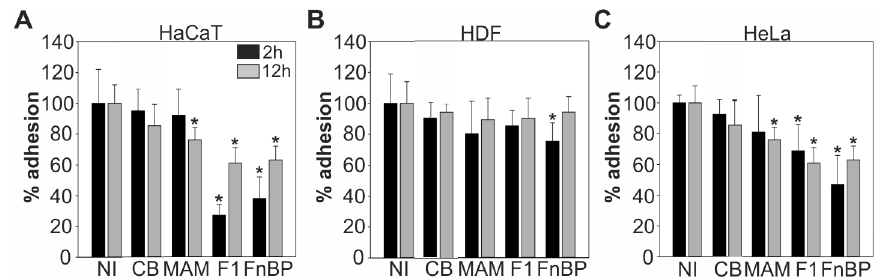
Figure 6. Effect adhesion inhibitors on host cellular adhesion in the presence of serum. Adhesion of HaCaT (A), HDF (B) or HeLa cells (C) to culture vessels was measured following 2 hours (black) or 12 hours (grey) of incubation in medium containing 10 % FBS alone (NI) or medium containing 500 nM immobilized GST (CB), MAM7, F1 or FnBPA peptide. Results are means ± standard deviation from one of a set of three experiments done in triplicate. Values significantly different from the control (p<0.01 according to student t-test) are indicated